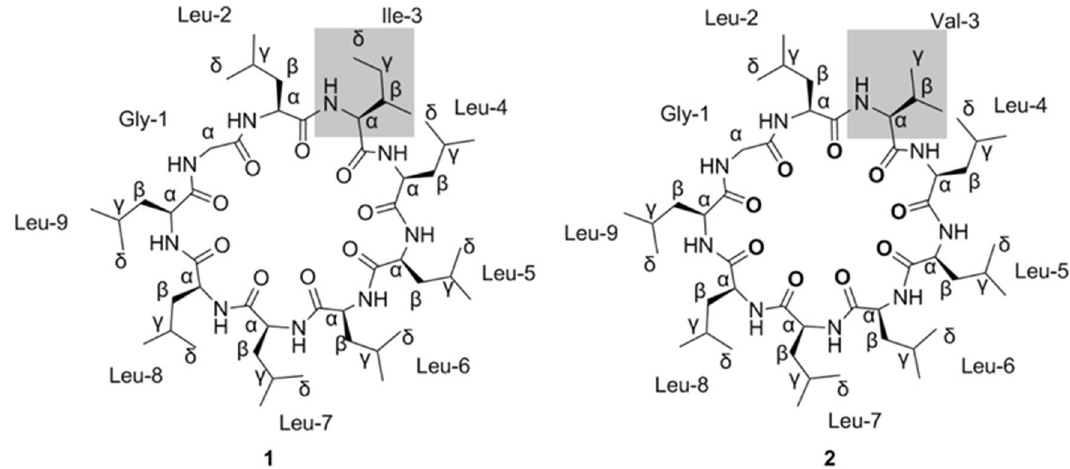
Fig. 1 Structures of compounds 1 and 2 from C.